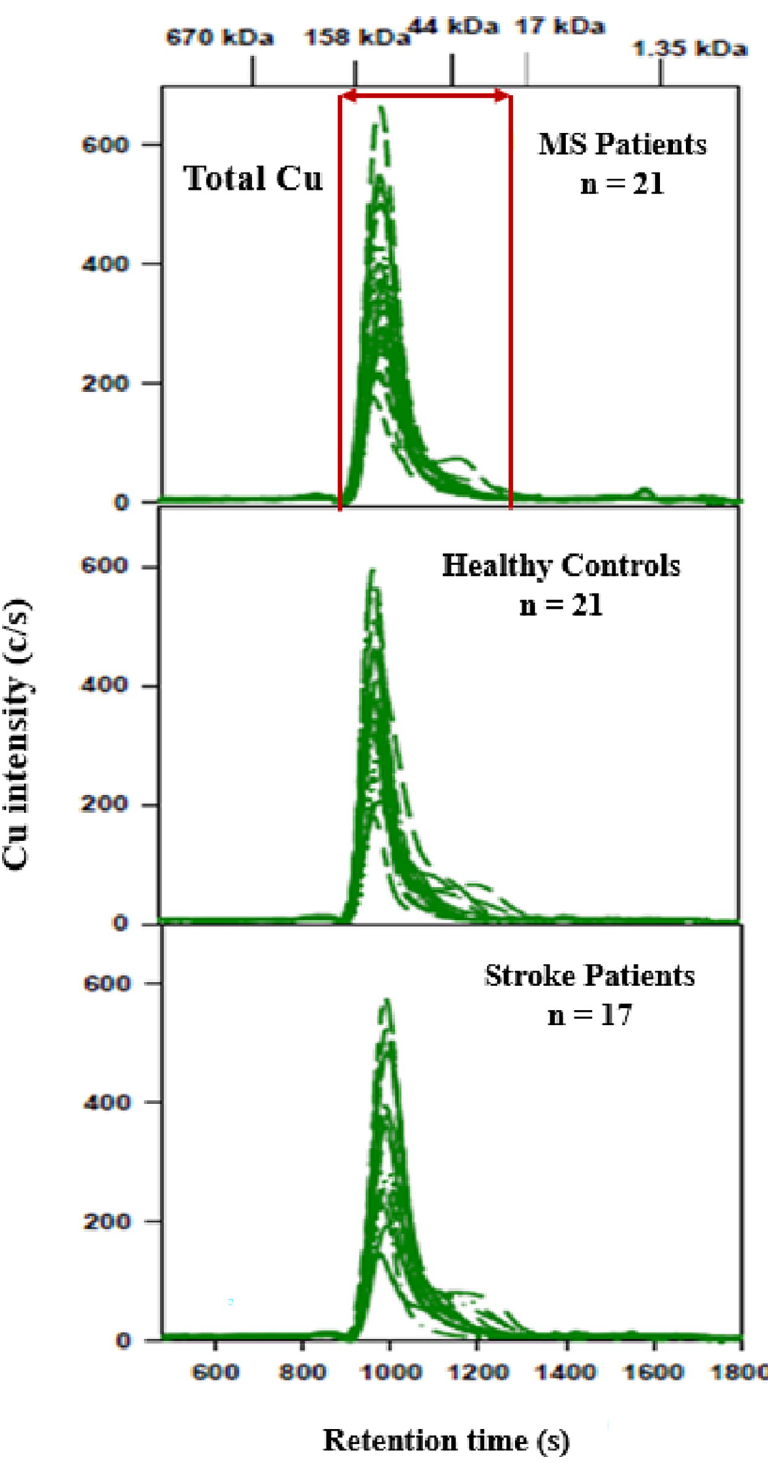
Fig 4. Cu-specific chromatograms obtained after the analysis of plasma from MS participants, AIS participants and healthy controls. Column: Superdex 200 Increase 10/300 GL (30 x 1.0 cm I.D., 8 μ m particle size), Temperature: 22˚C, Mobile phase: 150 mM PBS buffer (pH 7.4), Flow rate: 0.75 mL/min, Injection volume: 500 μ L. ICP-AES detection at 324.75 nm (Cu). Retention times of molecular weight markers are depicted on top. 750 μ L of plasma was diluted with 250 μ L of PBS buffer and 500 μ L of the obtained solution were injected on the SEC column.